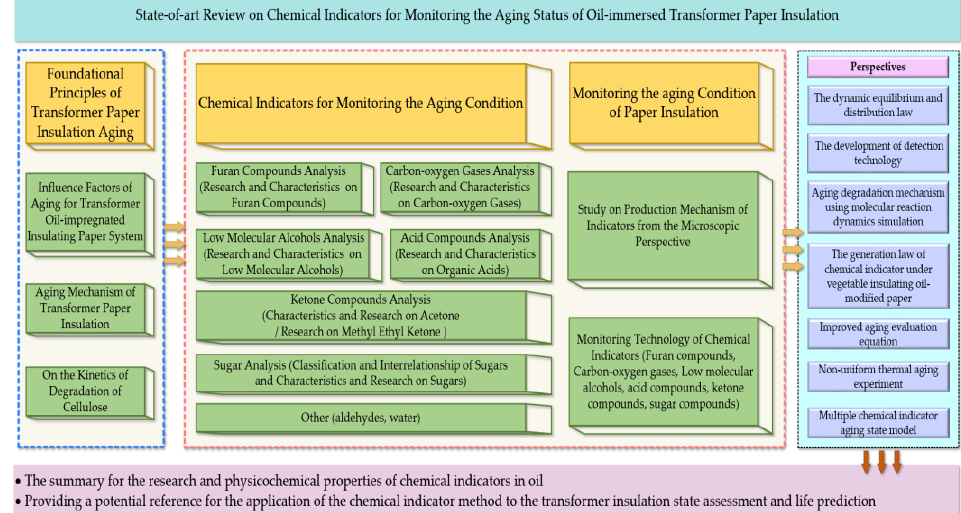
Figure 13. The logic of the existing research and perspectives of chemical indicators in oil.